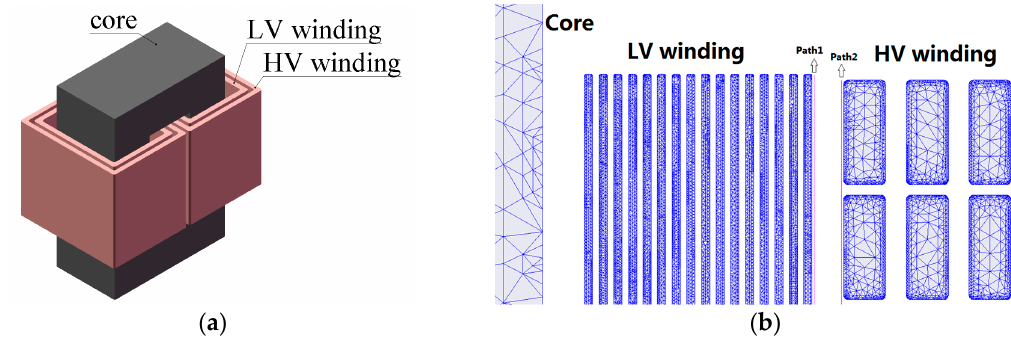
Figure 2. Instructions of this MFT: ( a ) Structure of the modeled MFT; ( b ) Meshed 2-D model.